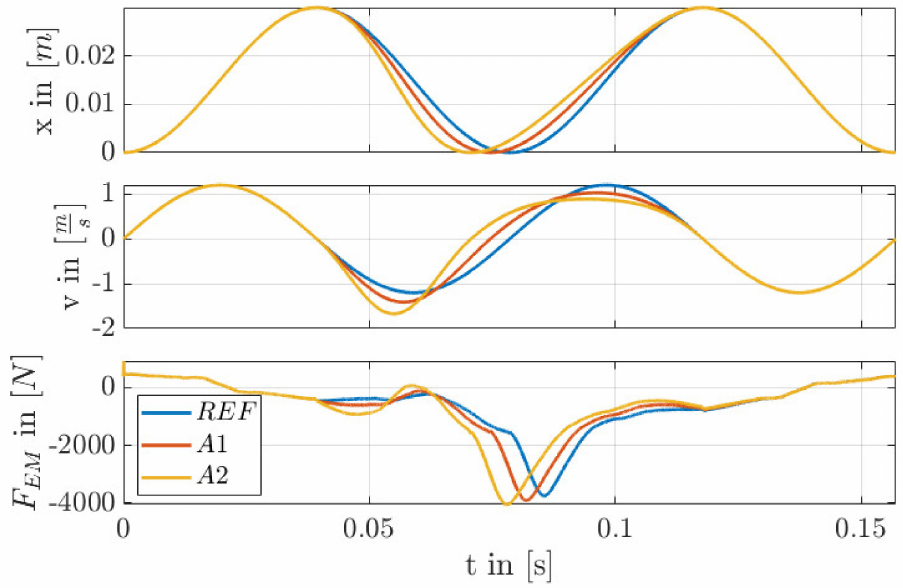
Figure 17. Comparison of trajectories REF, A1 and A2 related to the energy conversion of the electrical machine: illustration of the stroke, velocity and electric machine force depending on time.